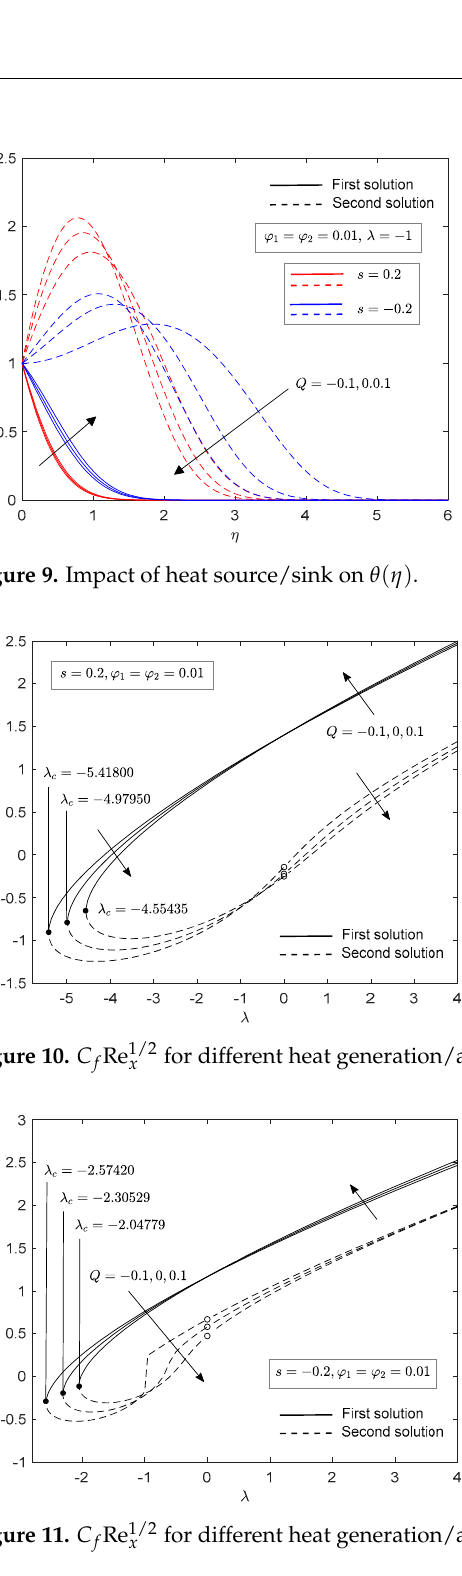
Figure 11. C f Re 1/2 x for different heat generation/absorption when s = − 0.2 .